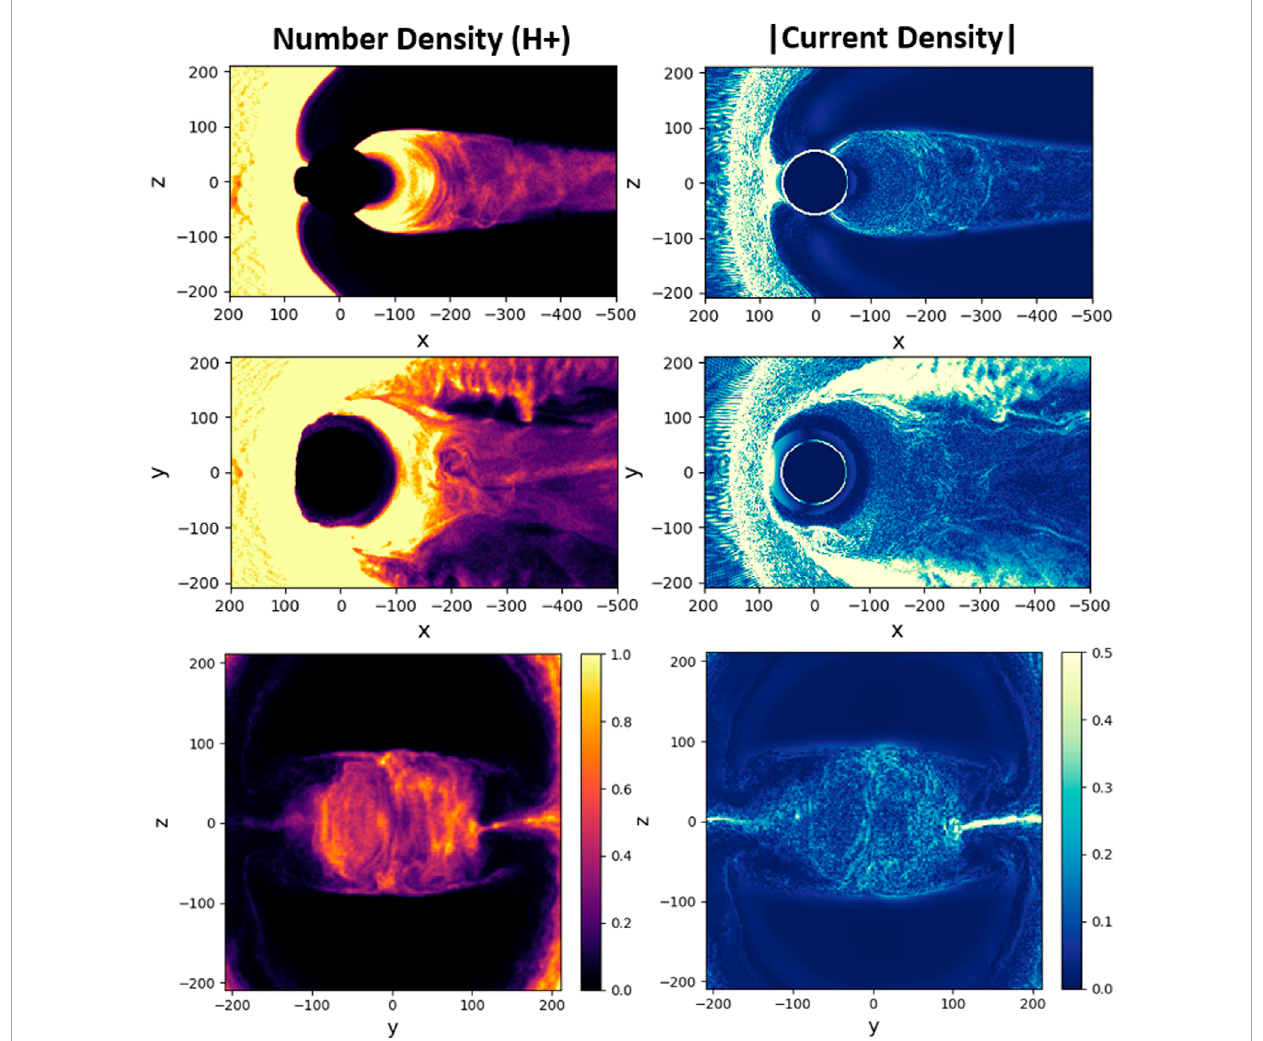
FIGURE 2 H+ number density and absolute value of net current density, | J | in three cross-sections in the baseline simulation (no outflow) at Ω cp t = 461: x–z ( y = 1